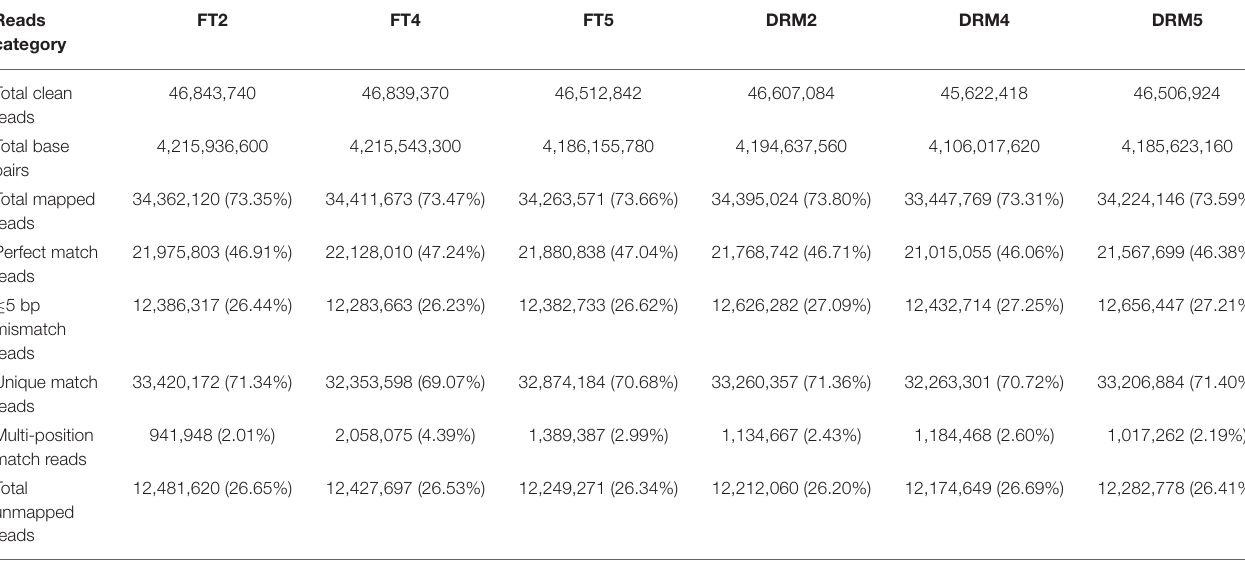
TABLE 3 | Number of reads based on Illumina sequencing data in six libraries of drm and